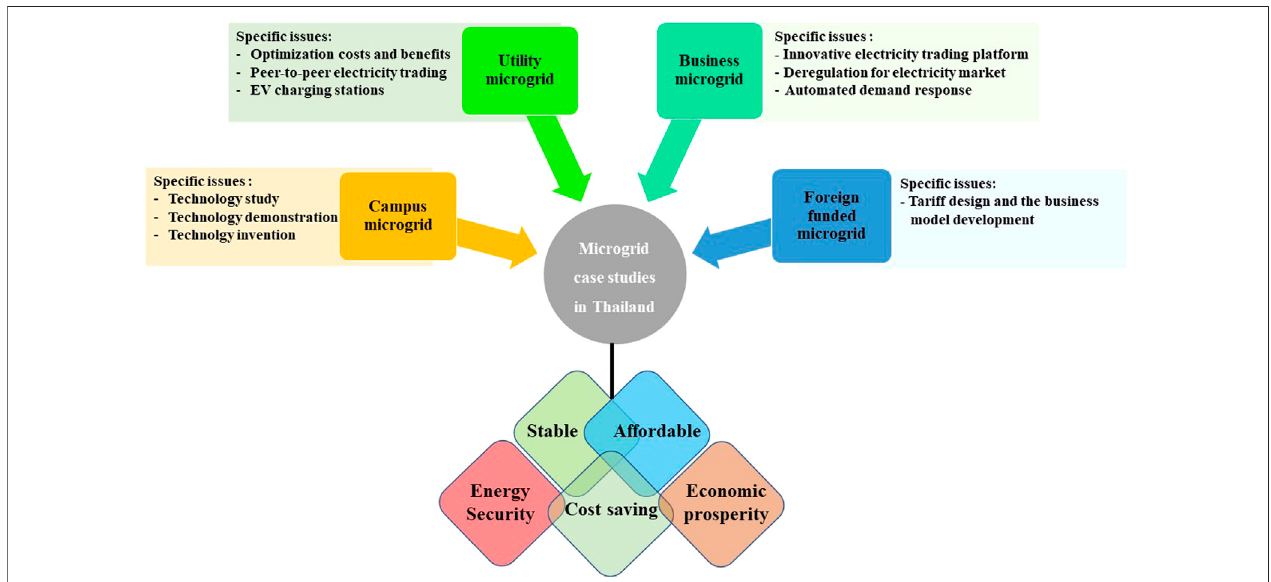
FIGURE 3 | Four types of microgrids in